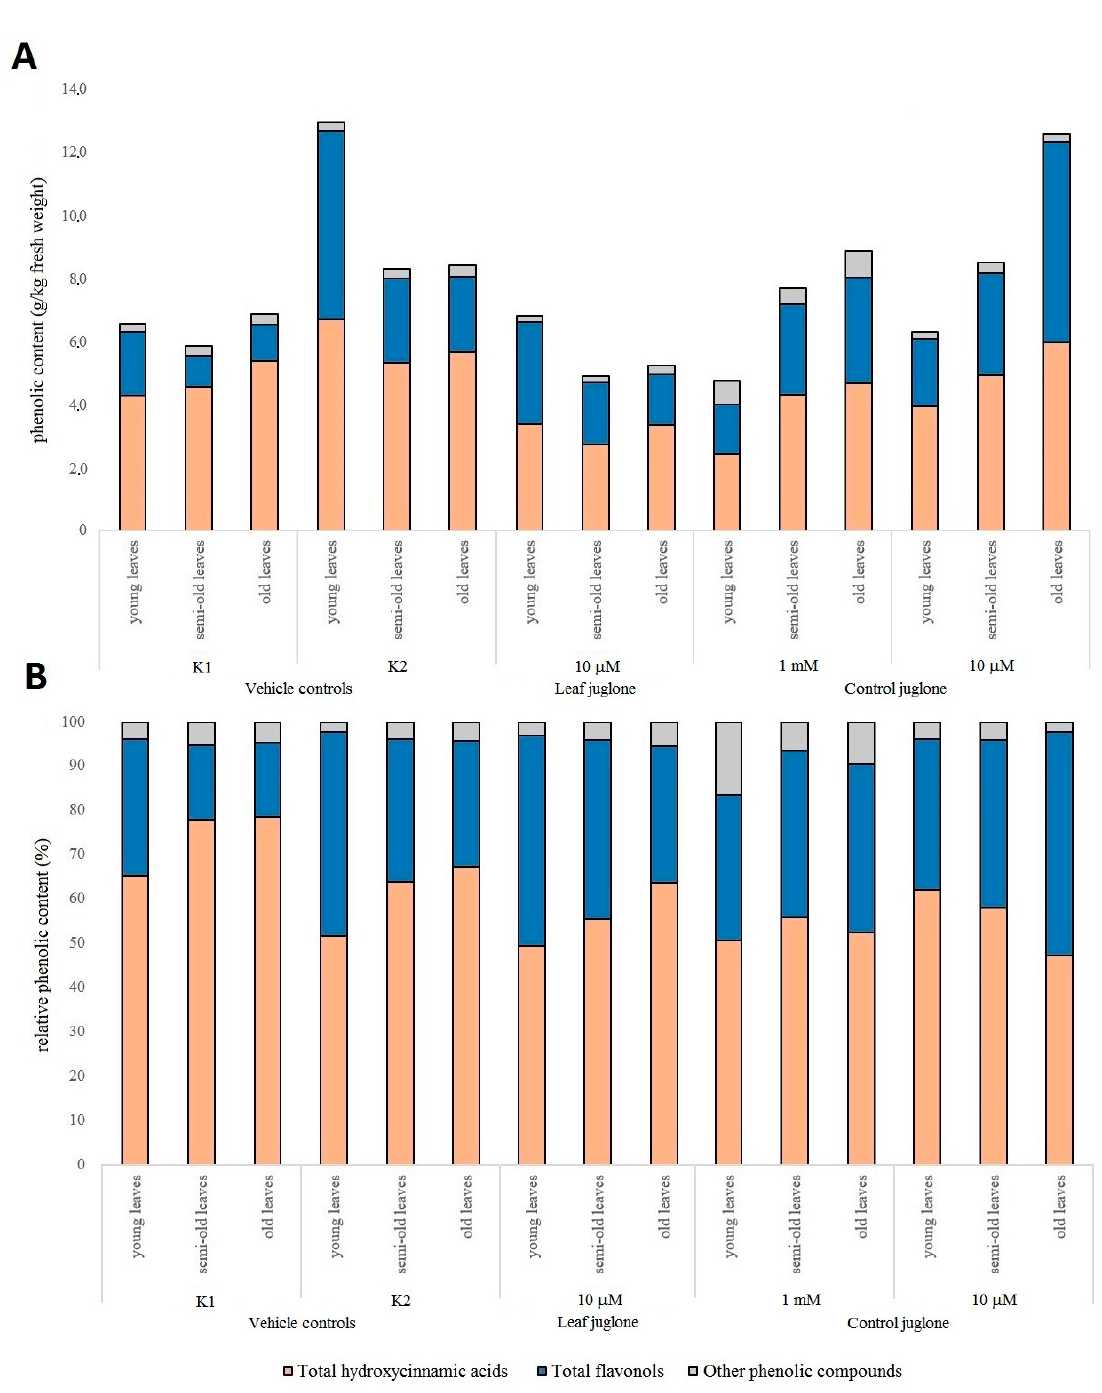
Figure 4. Contents of the total phenolic groups identified in L. sativa expressed relative to fresh weight ( A ) and as proportions of the total phenolic groups identified ( B ). K1: extraction medium control (0.17% DMSO, 0.17% ethanol in H 2 O); K2: water control. Young leaves, undeveloped leaves; semi-old leaves, remaining fully developed leaves; old leaves, four outer fully developed leaves.